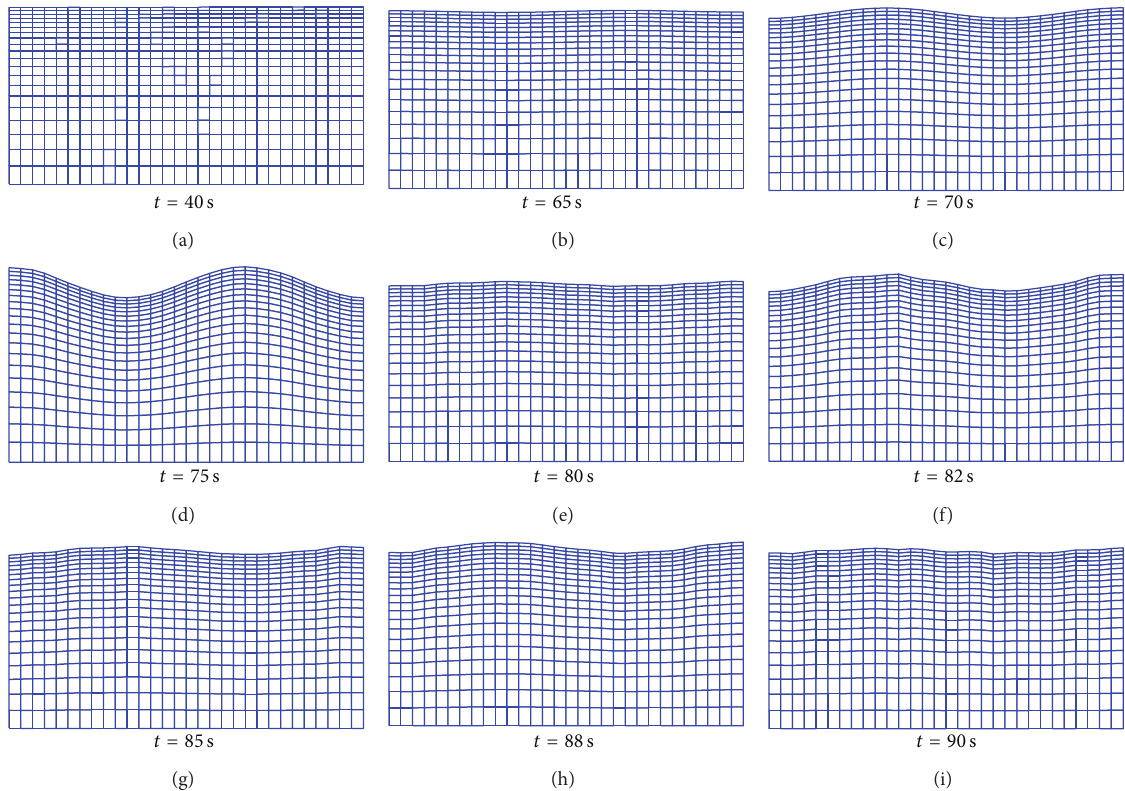
Figure 9: Moving mesh generated at different time steps in unstable region displaying detuning